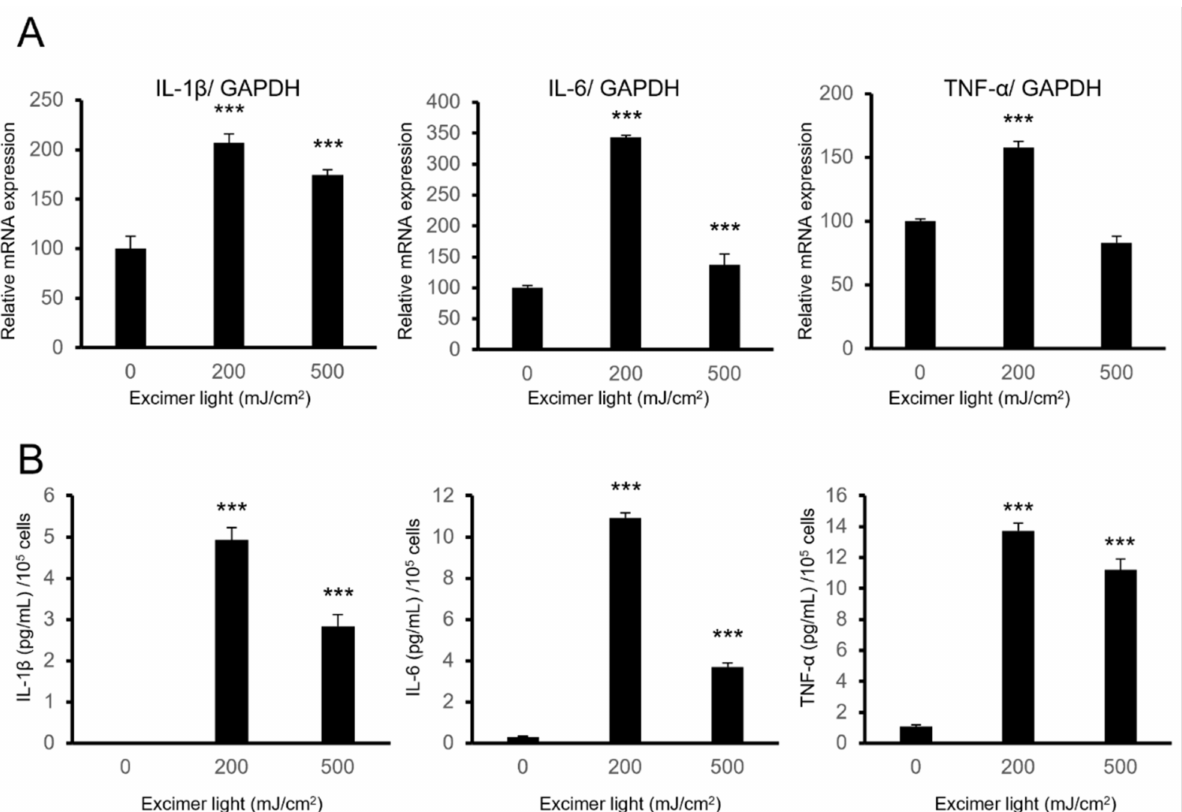
Figure 2. A toxic dose of monochromatic excimer light (MEL) irradiation induced IL-1 β , IL-6, and TNF- α in PSVK1 keratinocytes. ( A ) Relative mRNA expression levels of IL-1 β , IL-6, and TNF- α after 24 h irradiation with the indicated dose of MEL. ( B ) The protein expressions of IL-1 β , IL-6, and TNF- α in cultured supernatants using an ELISA assay after 48 h of irradiation with the indicated dose of MEL. Data are shown as the means ± SD, *** p < 0.01, one-way analysis of variance followed by Dunnett’s test vs. 0 mJ/cm 2